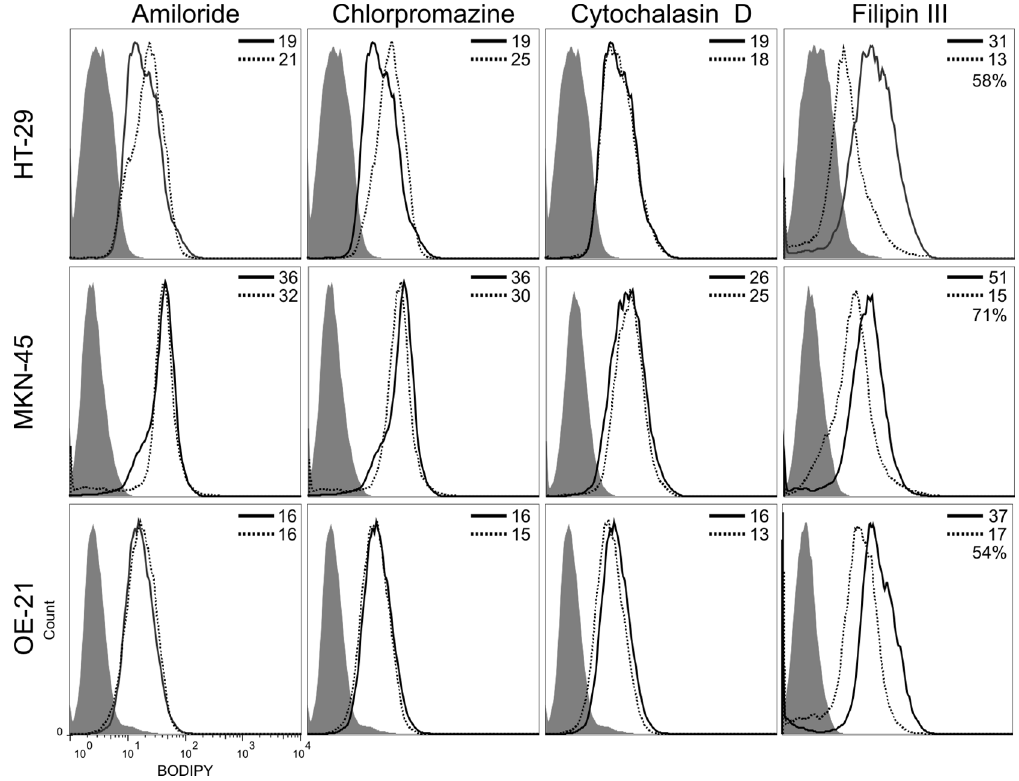
Figure 2. Endocytosis pathways involved in bioconjugate cell entry. HT-29, MKN-45 and OE-21 tumor cells were left untreated (solid line) or treated (dashed line) for 1 hour with selective chemical inhibitors of different pathways involved in endocytosis (amiloride, chlorpromazine, cytochalasin D and filipin III). Subsequently, cells were exposed for 30 minutes to ONCOFID-P and then treated with hyaluronidase for 4 hours, to be finally analyzed by flow cytometry. Data at the upper-right corner of each panel report the respective geo mean values, and the percentage of reduction induced by treatment.